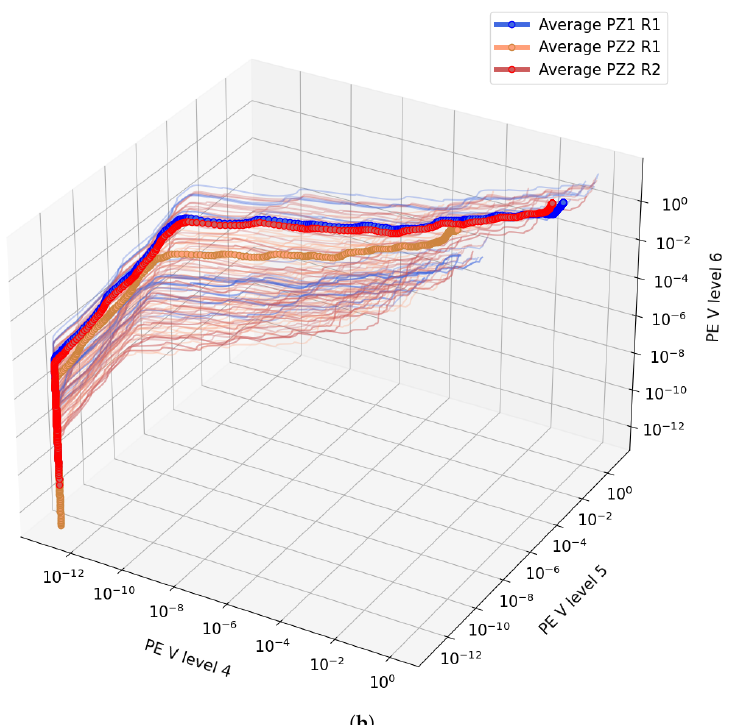
Figure 4. PE of the voltage TW per decomposition level. Each line represents the PE through time for a fault in a given PZ as measured by R1 or R2. ( a ) PE Levels 1 to 3. ( b ) PE Levels 4 to 6. Comparing faults in PZ1 R1 and PZ2 R1, it can be seen that the values for PZ2